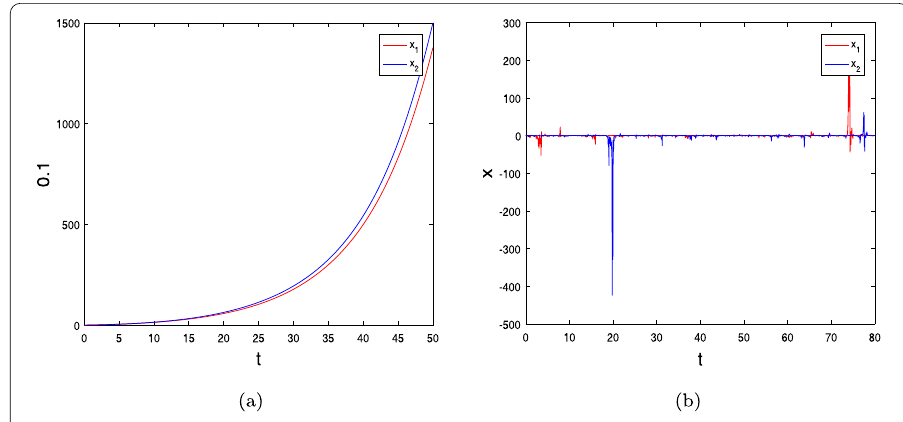
Figure 1 The left curve shows an unstable trajectory of X ( t ) generated by the EM scheme for system (27) without feedback control, while the right one shows a stable trajectory for system (28) by continuous noise with time delay τ = 0.015